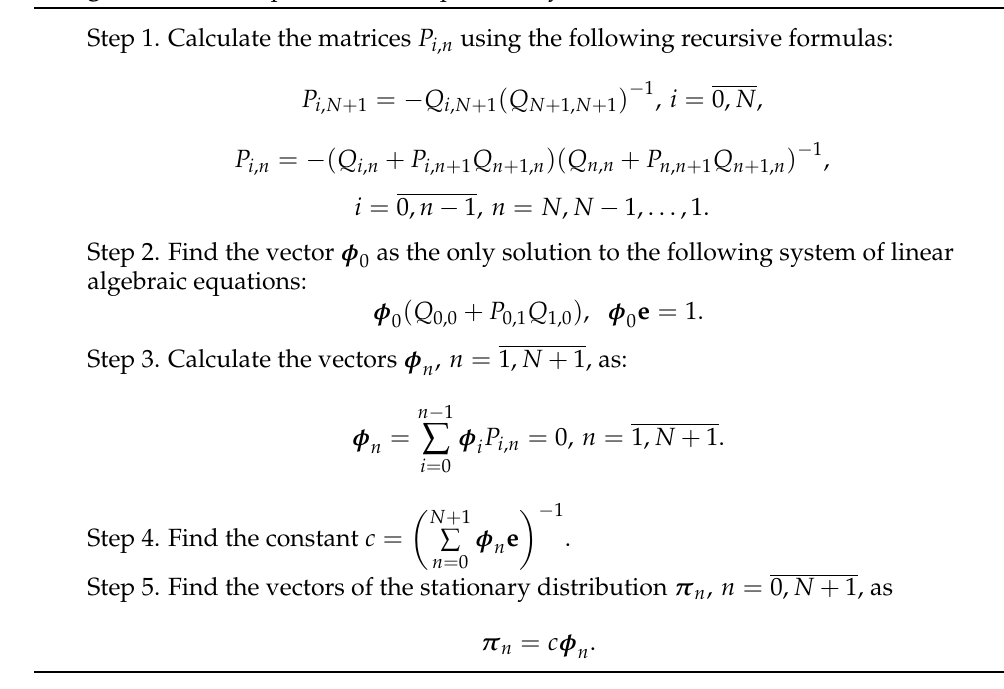
Algorithm 1: Computation of the probability vectors π n , n = 0, N +